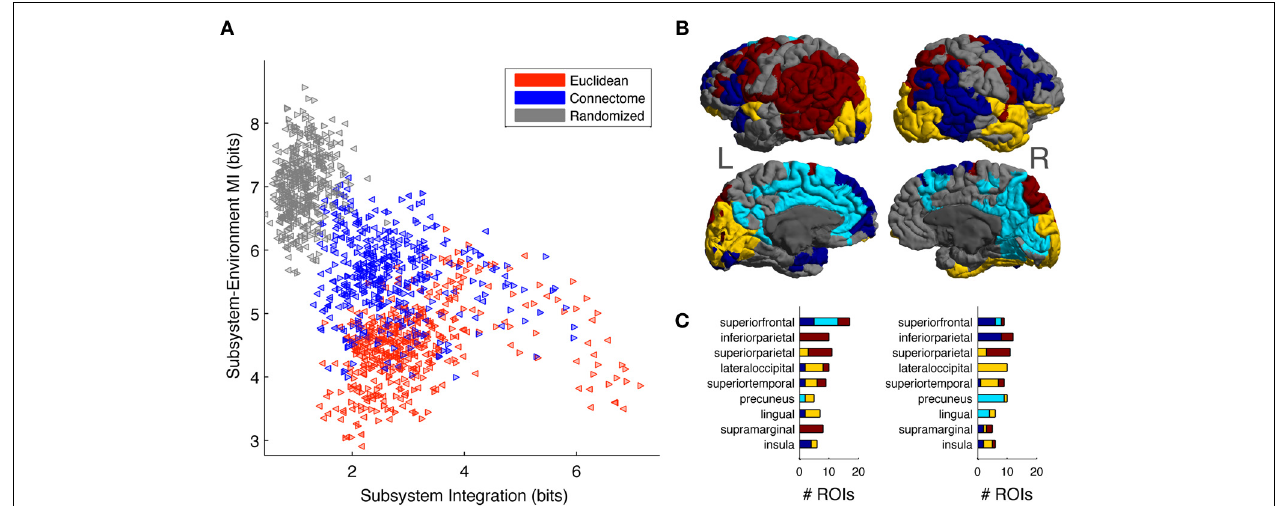
FIGURE 7 | (A) Scatter plot of Subsystem Integration vs. Subsystem-Environment MI for subsystems of size 11, with red, blue and gray colors correspond to subsystems chosen according to Euclidean, Connectome and Randomized metrics respectively. Left-hemisphere subsystems are indicated with left-pointing triangles and right-hemisphere subsystems are indicated with right-pointing triangles. (B) Connectome subsystems in the upper 50 percentile of both Subsystem Integration and Subsystem-Environment MI were chosen and allowed us to